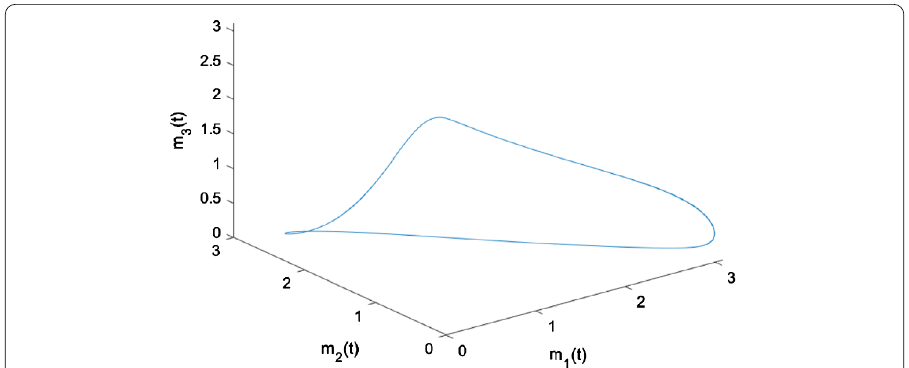
Figure 3 The limit cycle behavior of mRNAs